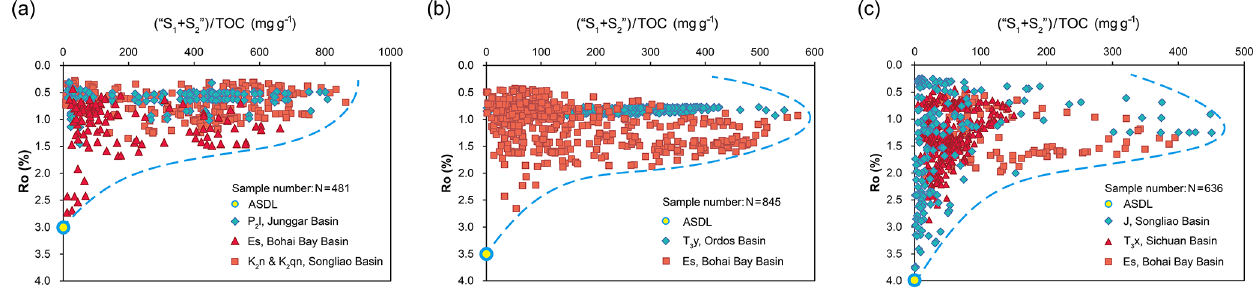
Figure 3. Effects of kerogen types on ASDLs represented by thermal maturity (Ro). From left to right are three plots of hydrocarbon generation potential index versus Ro for source rocks of type I (a) , type II (b) , and type III (c) .